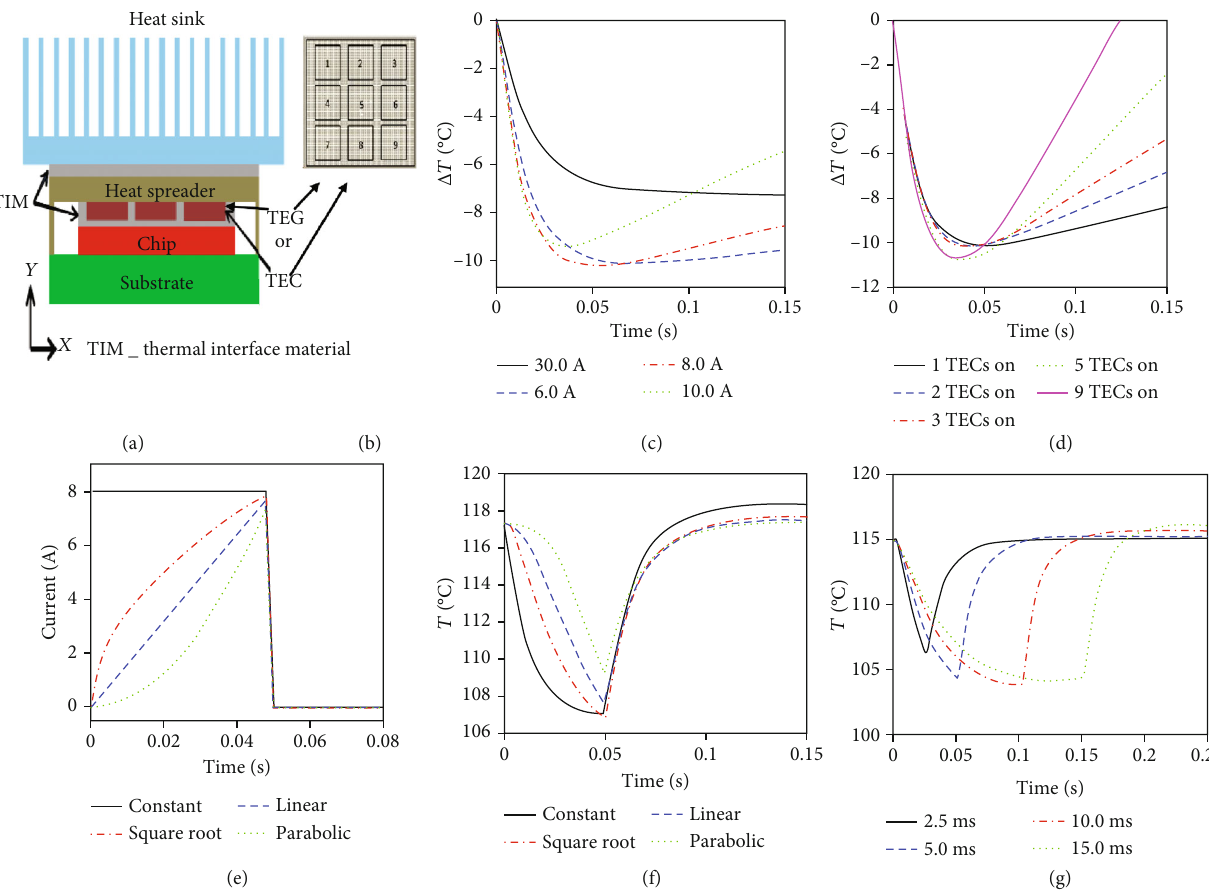
Figure 7: Simulation summary of the modelled on-chip TEC (adapted from